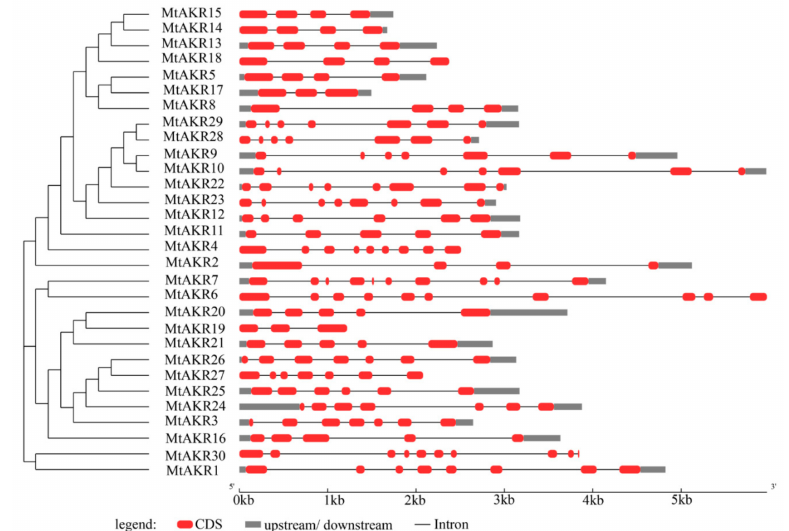
Figure 2. Structural and phylogenetic analyses of 30 identified MtAKR members. An unrooted tree of the MtAKR s constructed by neighbor-joining method, using MEGA 7. The gene organization of MtAKR s was explored by using the online tool GSDS 2.0 (http: // gsds.cbi.pku.edu.cn / Center for Bioinformatics, Peking University, Beijing,